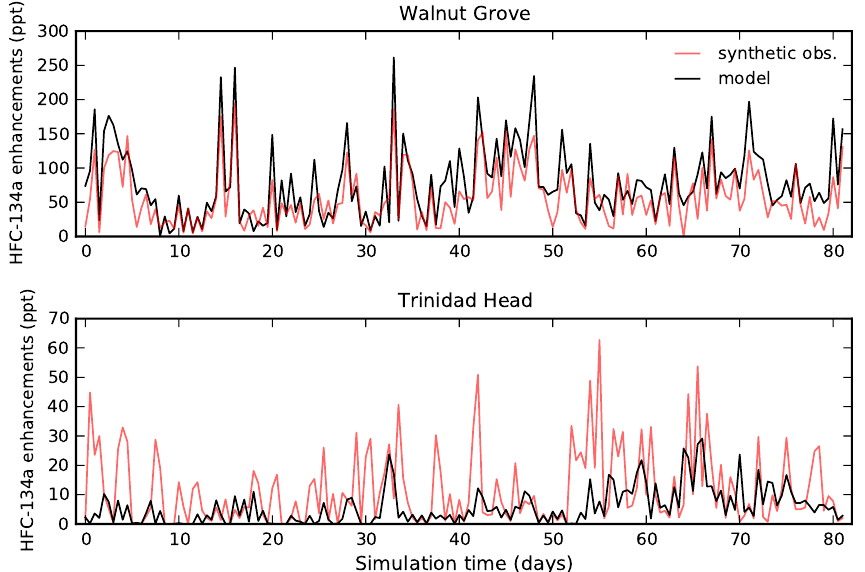
Figure 2. The figure shows the HFC-134a time series from the forward model simulations (black lines, ξ m ) and synthetic observations (red lines, ξ o ) at Walnut Grove (upper) and Trinidad Head (lower). Synthetic observations are generated using Eqs. (1) and (2). The time series are displayed using 1sampleday − 1 to clearly show the observation–model differences, though higher frequency sampling strategies are available and